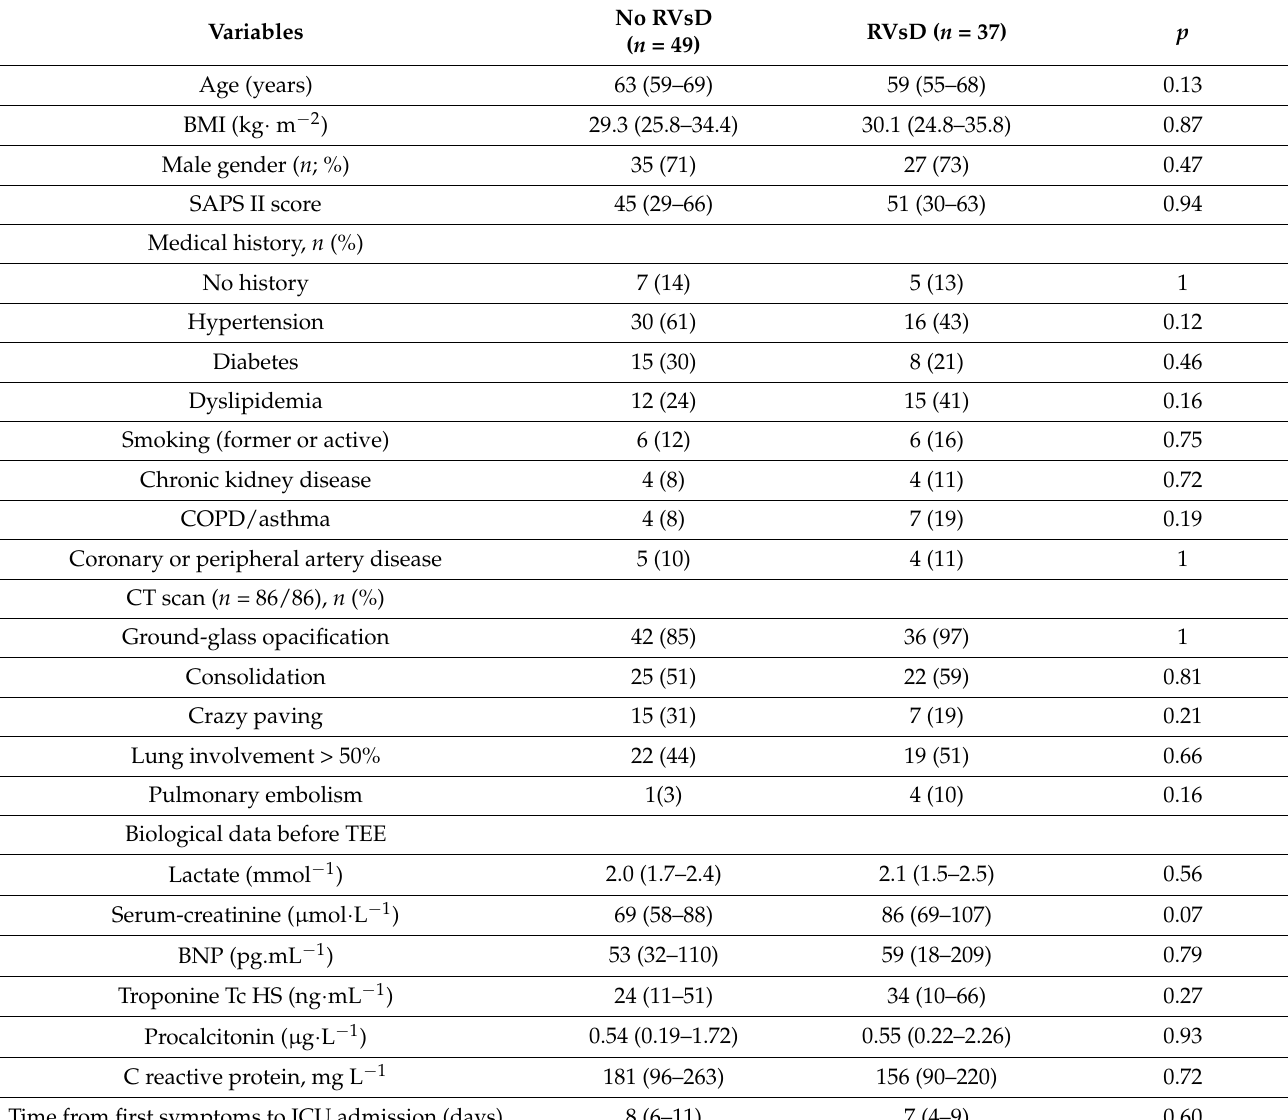
Table 1. Demographic, biological and computed tomography data before